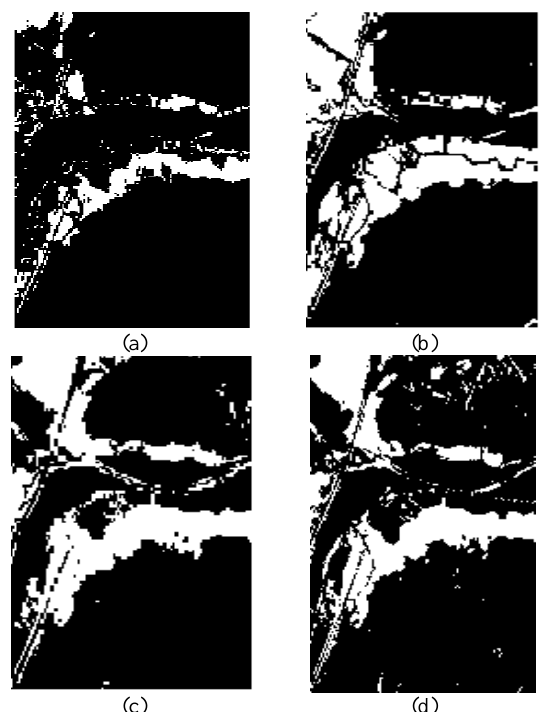
Figure 4. The results of CD methods for Shadegan wetland data set. (a) IR-MAD, (b) PCA, (c) Proposed method-binary change the map, (d) Ground truth.